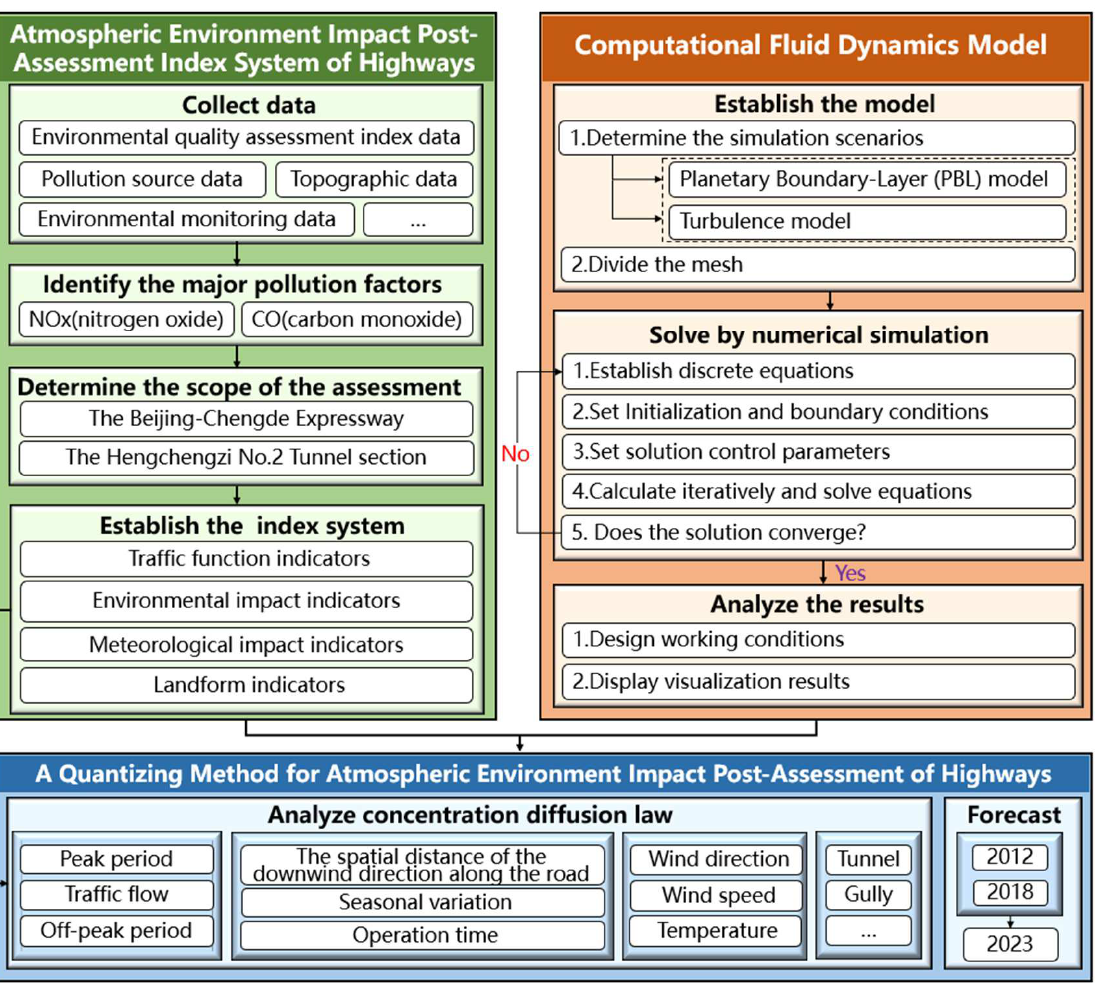
Figure 1. Research route.